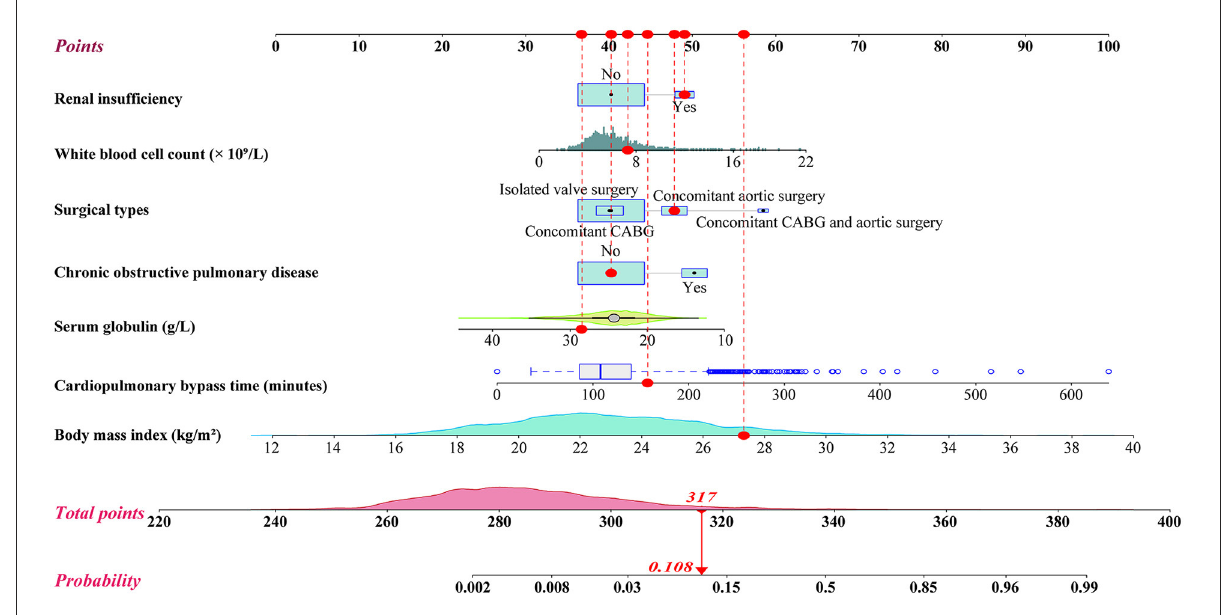
FIGURE1 Nomogram for the prediction of severe hypoxemia after heart valve surgery.